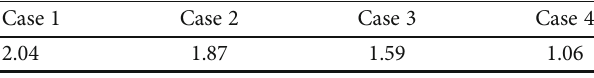
Figure 9: Fracture development under di ff erent stress conditions. (a) σ MPa; (d) σ h = 70 MPa, σ v = 30 MPa. Table 5: Area of blanked elements (unit: m 2